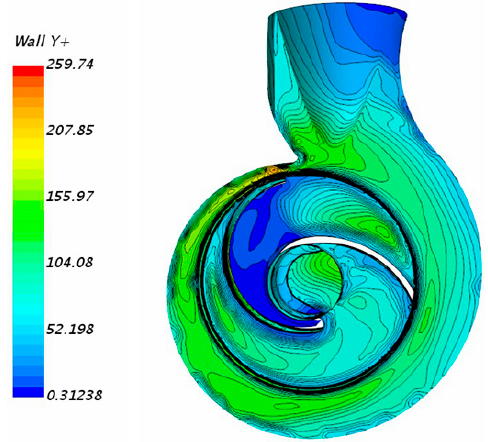
Figure 3. Distribution of y+ for the impeller and volute.